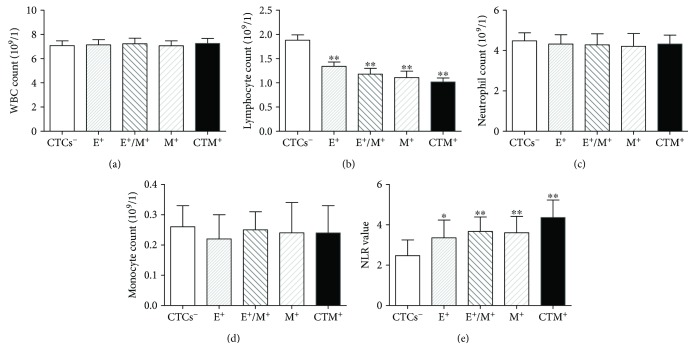
Quantification of WBCs in patients with colorectal cancer. (a) Total WBC, (b) lymphocytes, (c) neutrophils, (d) monocytes, and the NLR in patients lacking CTCs or positive for E-CTCs, M-CTCs, or E/M-CTCs. ∗P < 0.05 and ∗∗P < 0.01. WBC, white blood cell; NLR, neutrophil-to-lymphocyte ratio; CTC, circulating tumor cell; E, epithelial; M, mesenchymal.